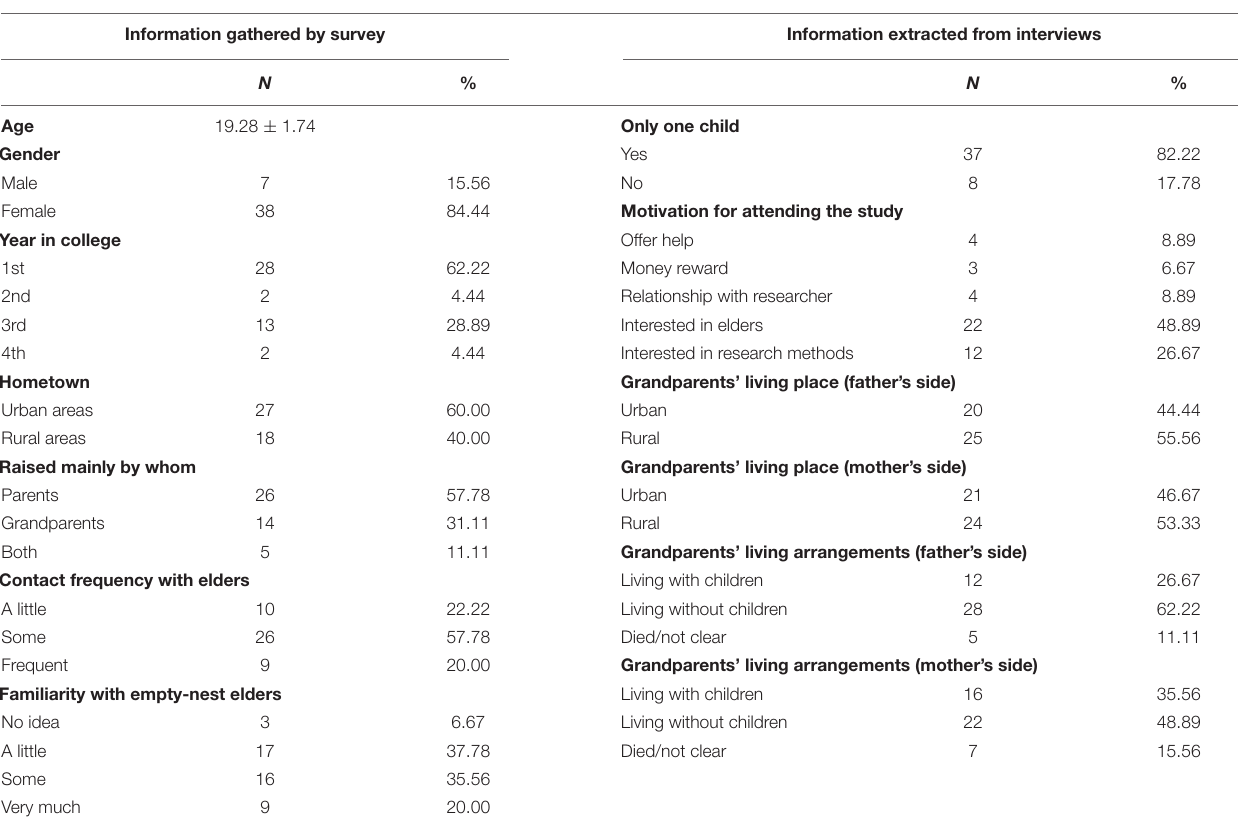
TABLE 1 | Participants’